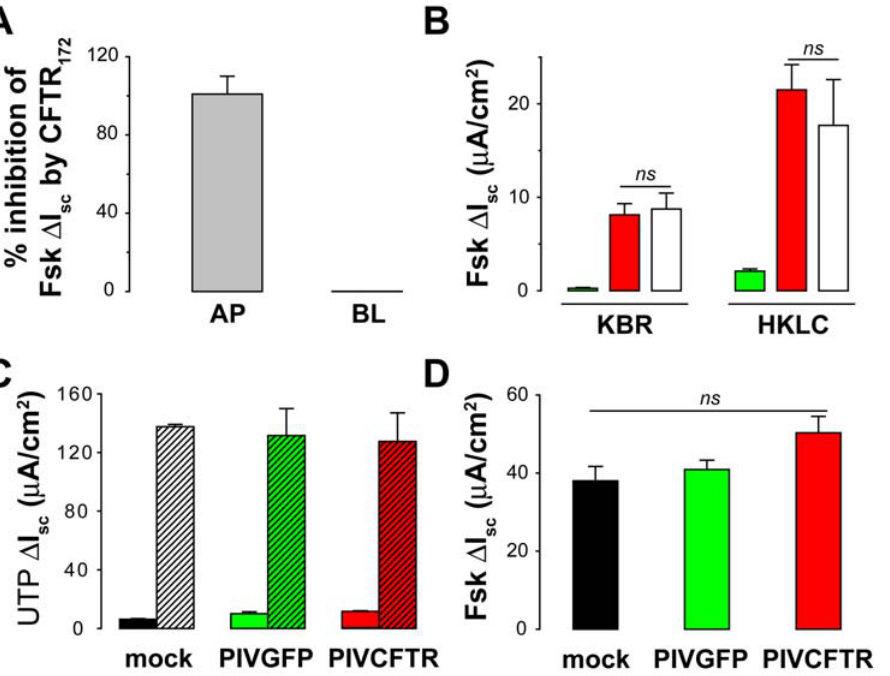
Figure 4. CFTR activity in ciliated cells is regulated by factors other than CFTR levels. (A) Percentage inhibition of Fsk-activated CFTR by CFTR 172 applied to either the apical (AP) or basolateral (BL) surfaces of PIVCFTR-corrected CF HAE. CFTR activity was inhibited by apical, but not basolateral, addition of CFTR 172 for at least 15 min ( n =4). (B) Driving force for Cl 2 secretion does not dictate magnitude of the Fsk response determined by measurement of Fsk-mediated D I sc under physiological Cl 2 concentration (KBR) or Cl 2 -free solutions (HKLC) in CF HAE 48 h after inoculation by PIVGFP (green bars) or PIVCFTR (red bars) and compared to non-CF HAE (white bars) ( n =8). (C) UTP-mediated Cl 2 secretion in KBR (solid bars) and HKLC (hatched bars) bathing solutions after inoculation of CF HAE with vehicle alone (black bars), PIVGFP (green bars), or PIVCFTR (red bars) ( n =6). Note that under conditions of increased driving force for Cl 2 secretion, responses far exceed the maximal responses achieved with Fsk-mediated CFTR activation in the presence of overexpressed CFTR. (D) Fsk-induced D I SC in non-CF HAE inoculated with mock (black bars), PIVGFP (green bars), or PIVCFTR (red bars), showing that overexpression of CFTR on top of endogenous CFTR does not significantly enhance the Fsk- mediated secretory response under physiological conditions ( n =5 for each). ns denotes not significantly different. Error bars indicate SEM .